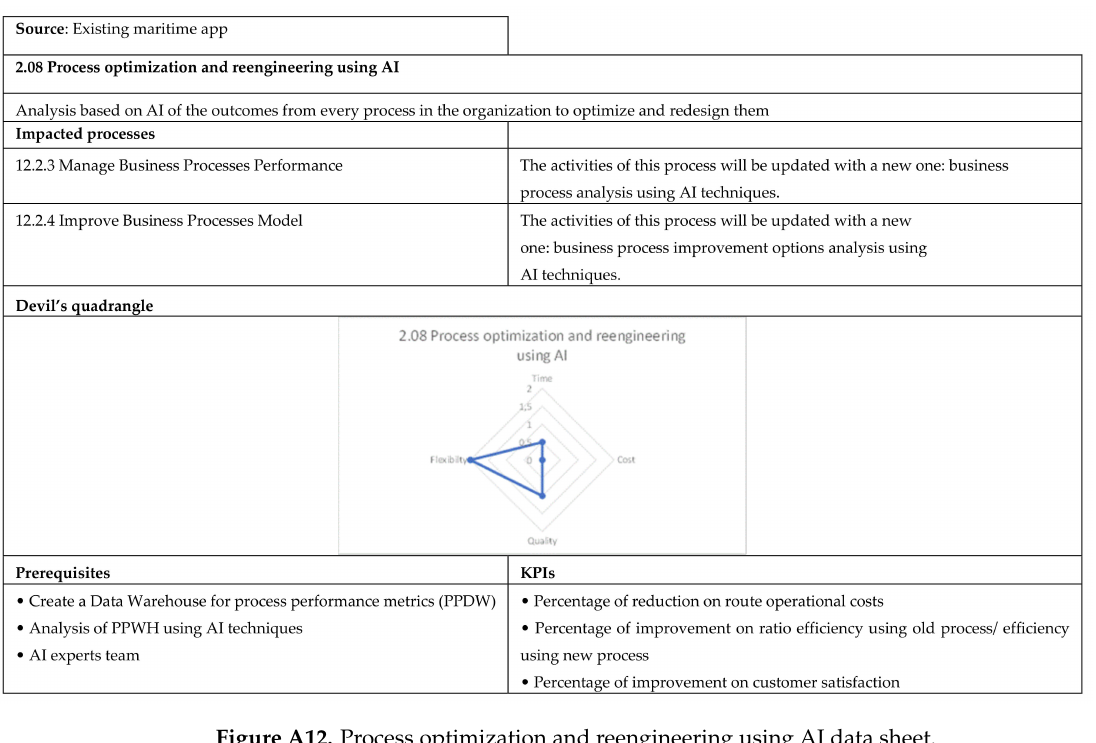
Figure A12. Process optimization and reengineering using AI data sheet.